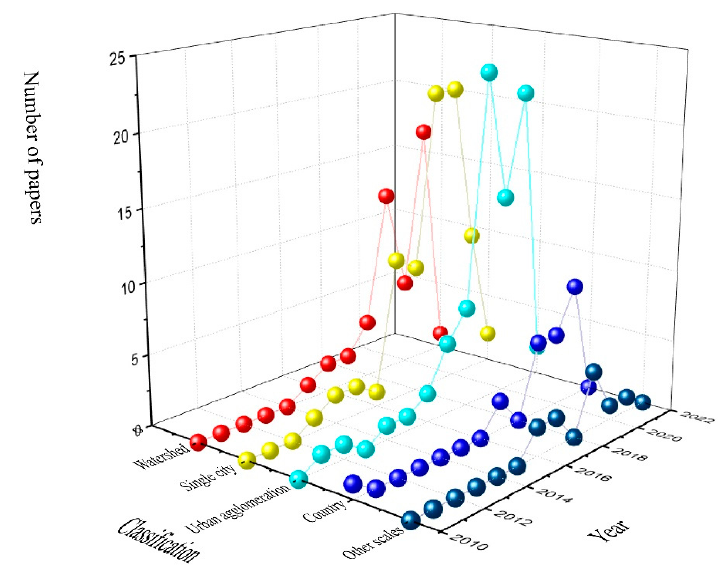
Figure 8. The distribution of the number of international trade-off studies. The numbers in the figure are the number of trade-off studies in each region.